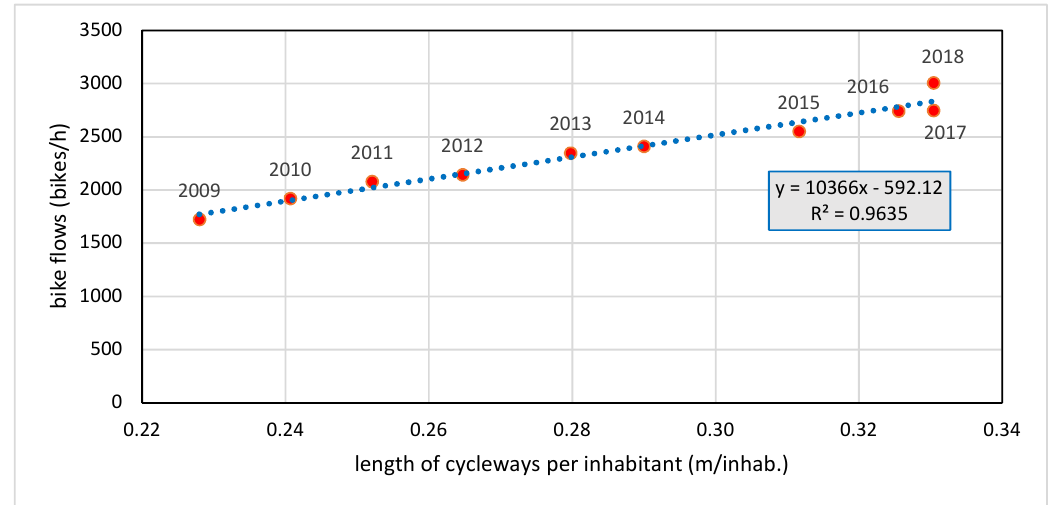
Figure 4. Regression function between length of cycleways per inhabitant and bike flows.